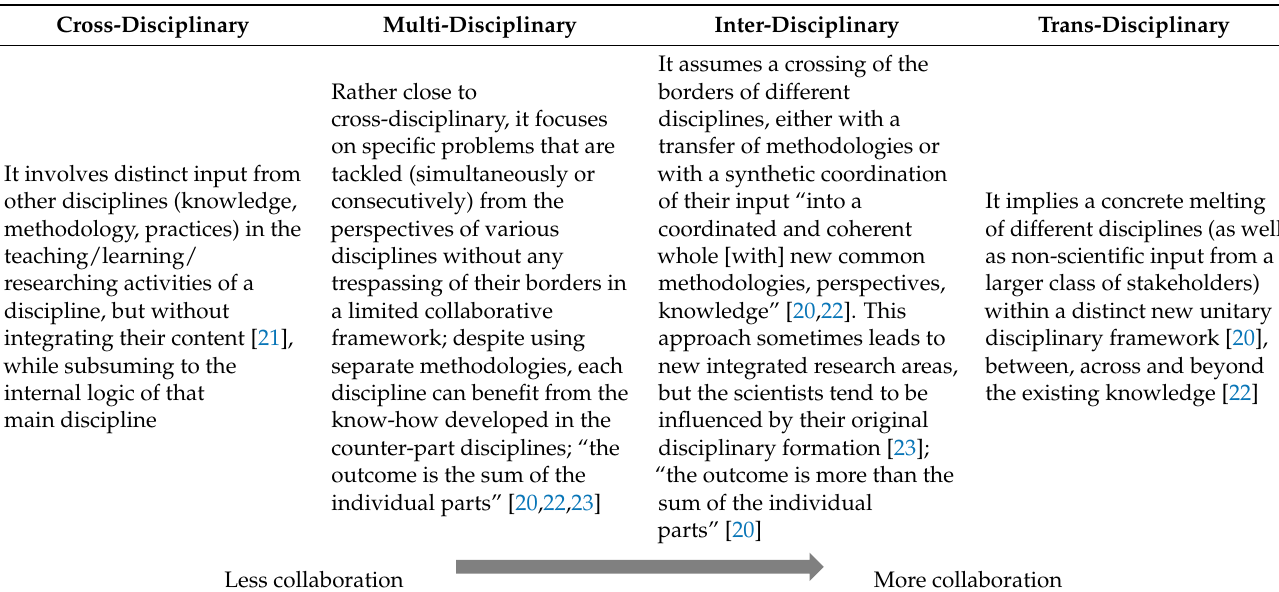
Table 1. Authors’ vision on the multiple disciplinarity approaches.